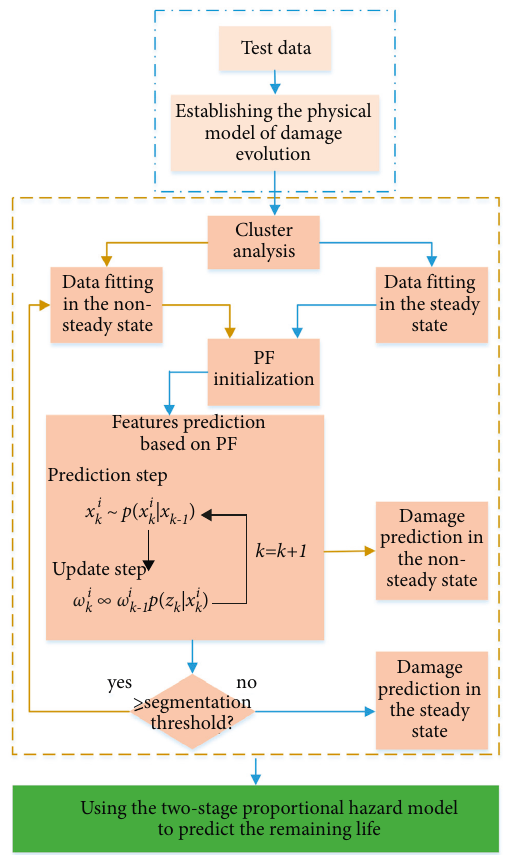
Figure 3: The framework to predict the remaining useful life of the scroll